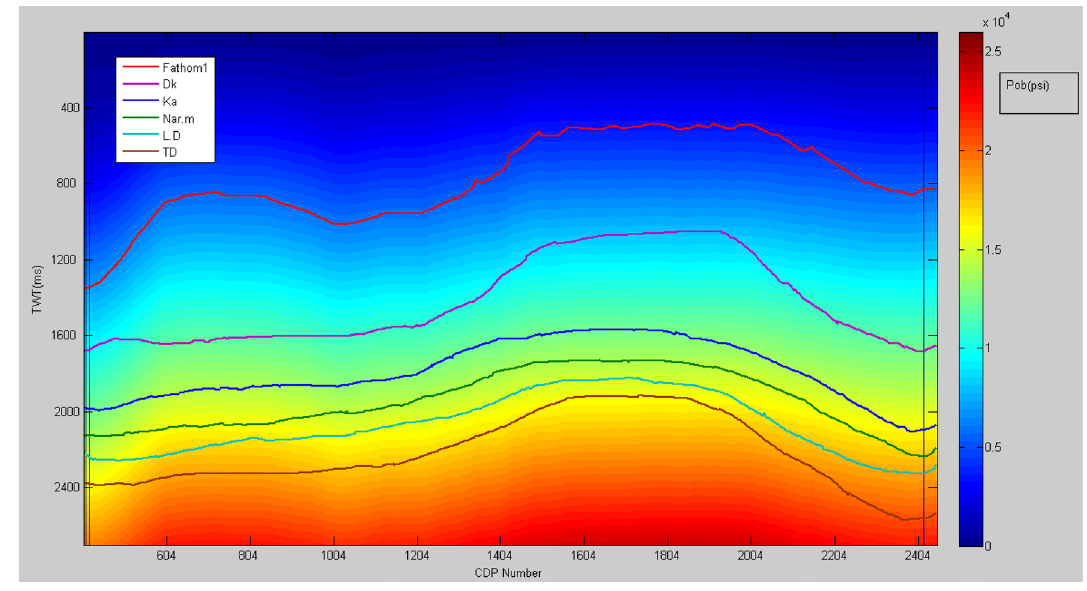
Fig. 8 Overburden pressure model of the Sefid-Zakhor